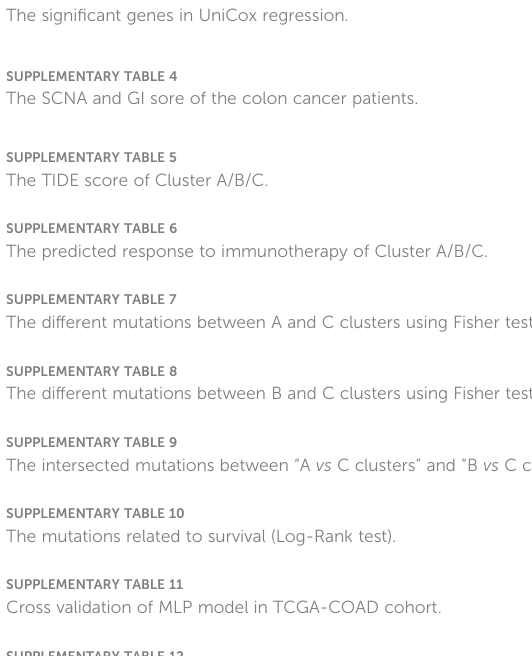
SUPPLEMENTARY TABLE 3 The signi fi cant genes in UniCox regression.